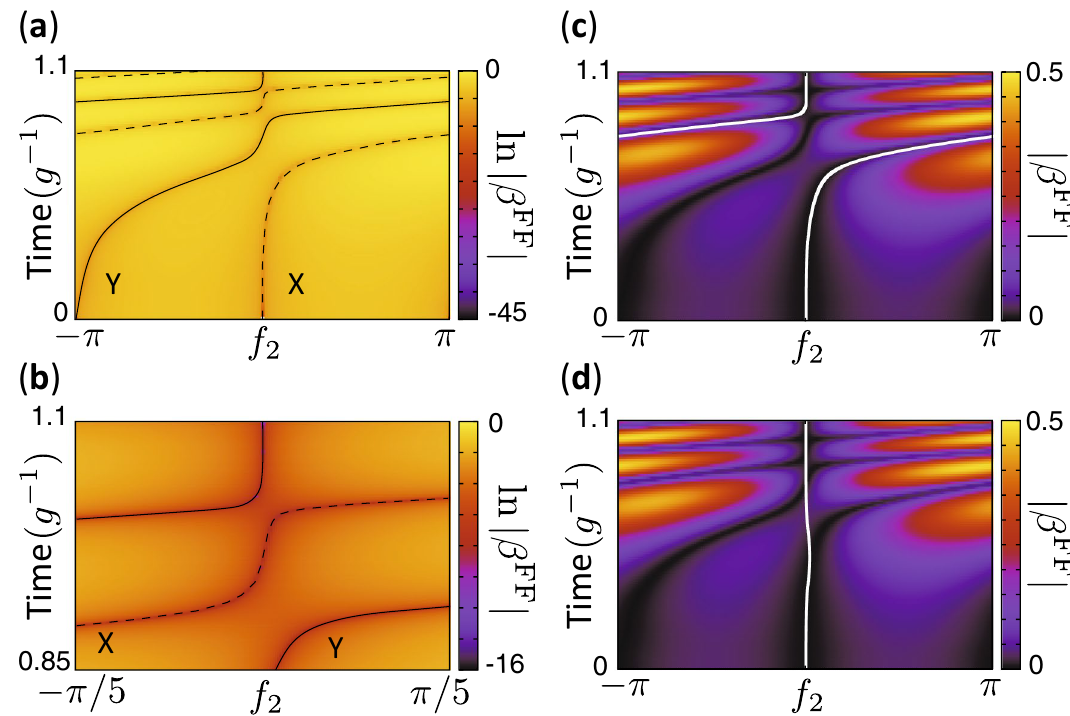
Figure 5. Speed-controlled and virtual trajectories for deceleration. ( a ) ln | β FF | as a function of f 2 and t for T F = 1.1 g − 1 . Other parameters used are the same as in Fig. 1b. The dashed and solid curves indicate SCT-X and SCT-Y. The dashed line does not reach f 2 = 0 at t = 1.1 g − 1 . ( b ) A closeup of ( a ). ( c ) VT-A indicated by the white curve interpolating the speed-controlled trajectories at around t = 0.9 g − 1 . ( d ), VT-B interpolating the speed-controlled trajectories at around t = 0.7 g − 1 and 0.9 g − 1 . The color in ( c,d ) shows | β FF | as a function of f 2 and